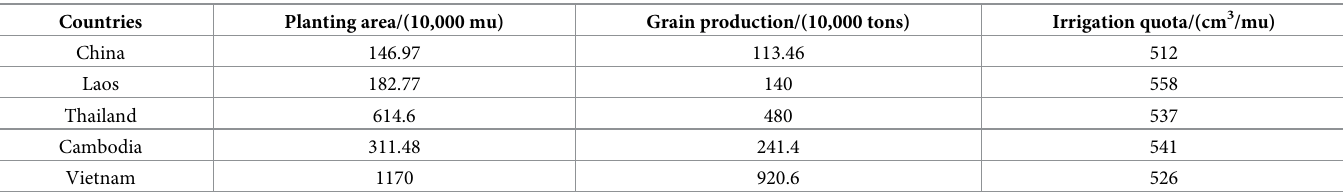
Table 2. Crop status of five countries in the Lancang-Mekong River Basin. Countries Planting area/(10,000 mu)